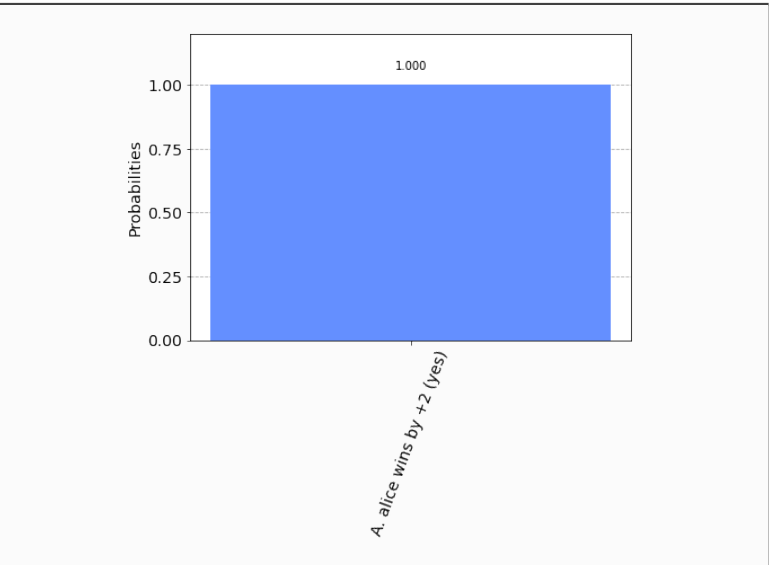
Figure 3. The case where both parties behave classically, by setting their free will radii to 0. In this case the parliament is classical and the voting outcome is certain with probability